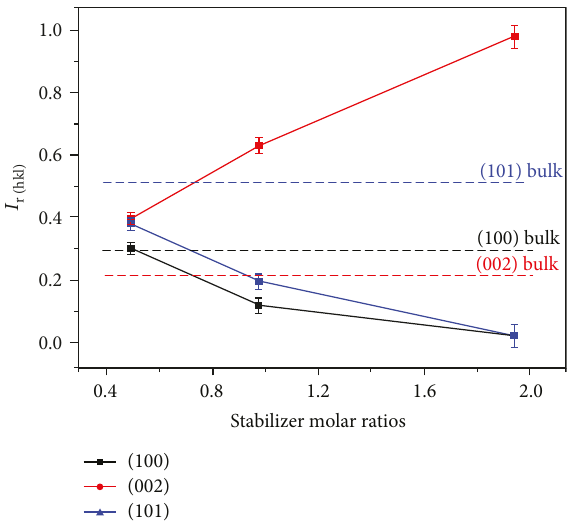
Figure 6: Relative intensity ratio of ZnO fi lms obtained using di ff erent stabilizer molar ratios.